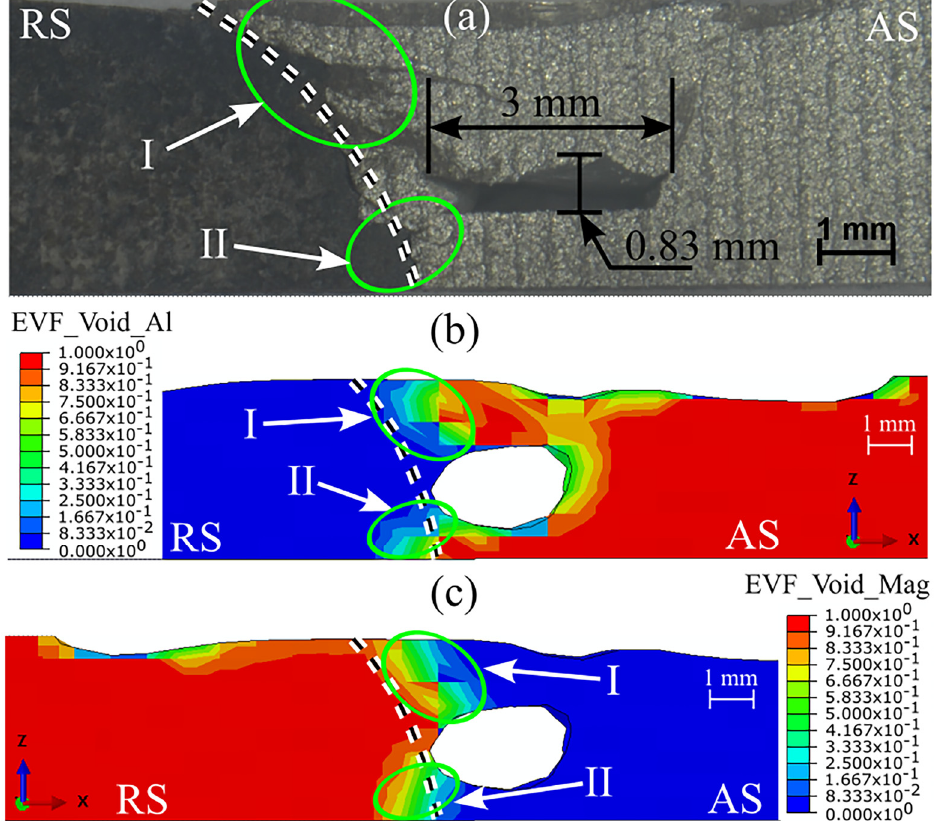
Figure 10. The visualization of the material mixing and prediction of the interface line in AA6061– AZ31B dissimilar FSW: ( a ) the experimental result, and ( b ) AA6061 and ( c ) AZ31B when welding at 900 rpm and 30 mm/min.